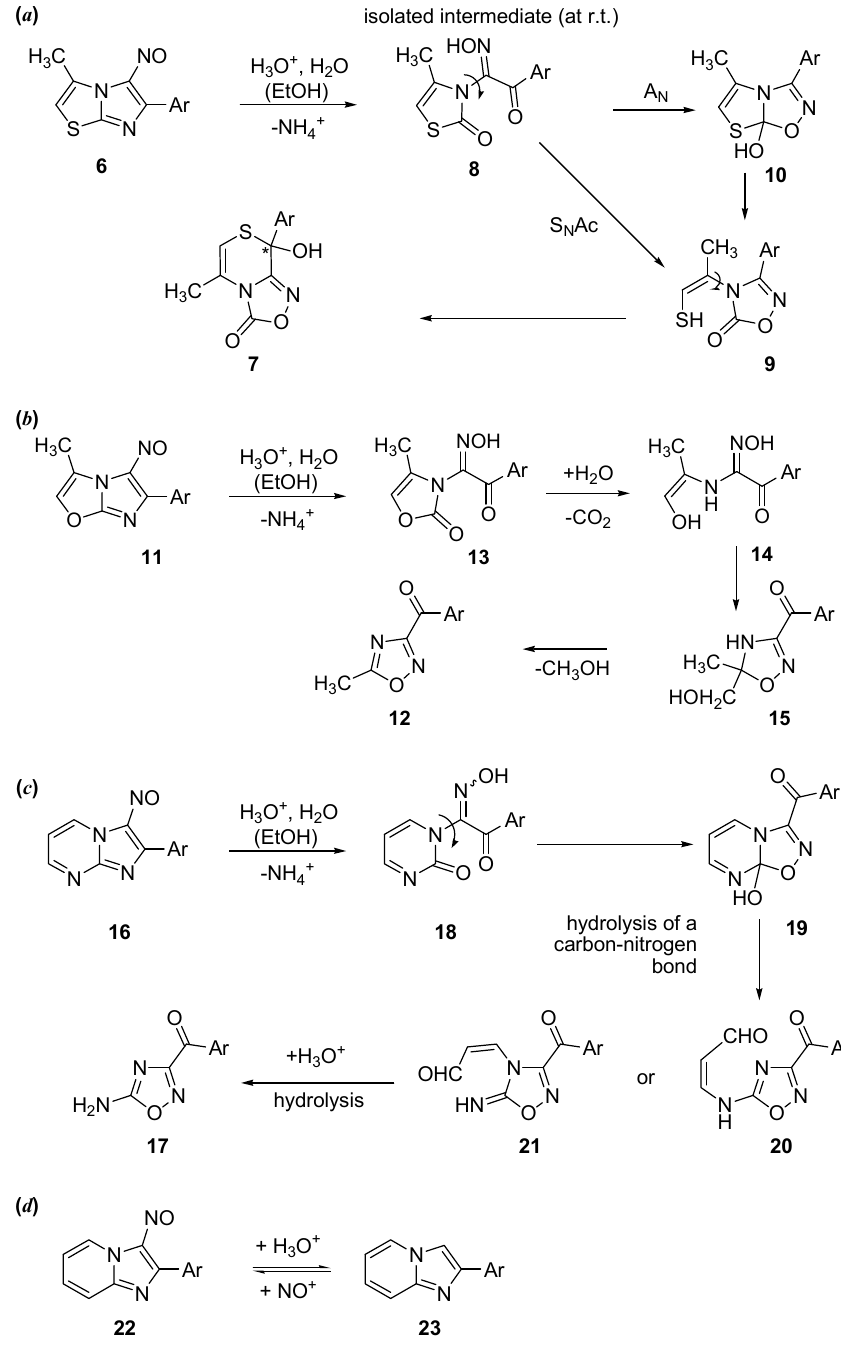
Scheme 2. Mechanisms for different nitrosoimidazoles, condensed with thiazole ( a ), oxazole ( b ), pyrimidine ( c ) and pyridine ( d ). Ar stands for para